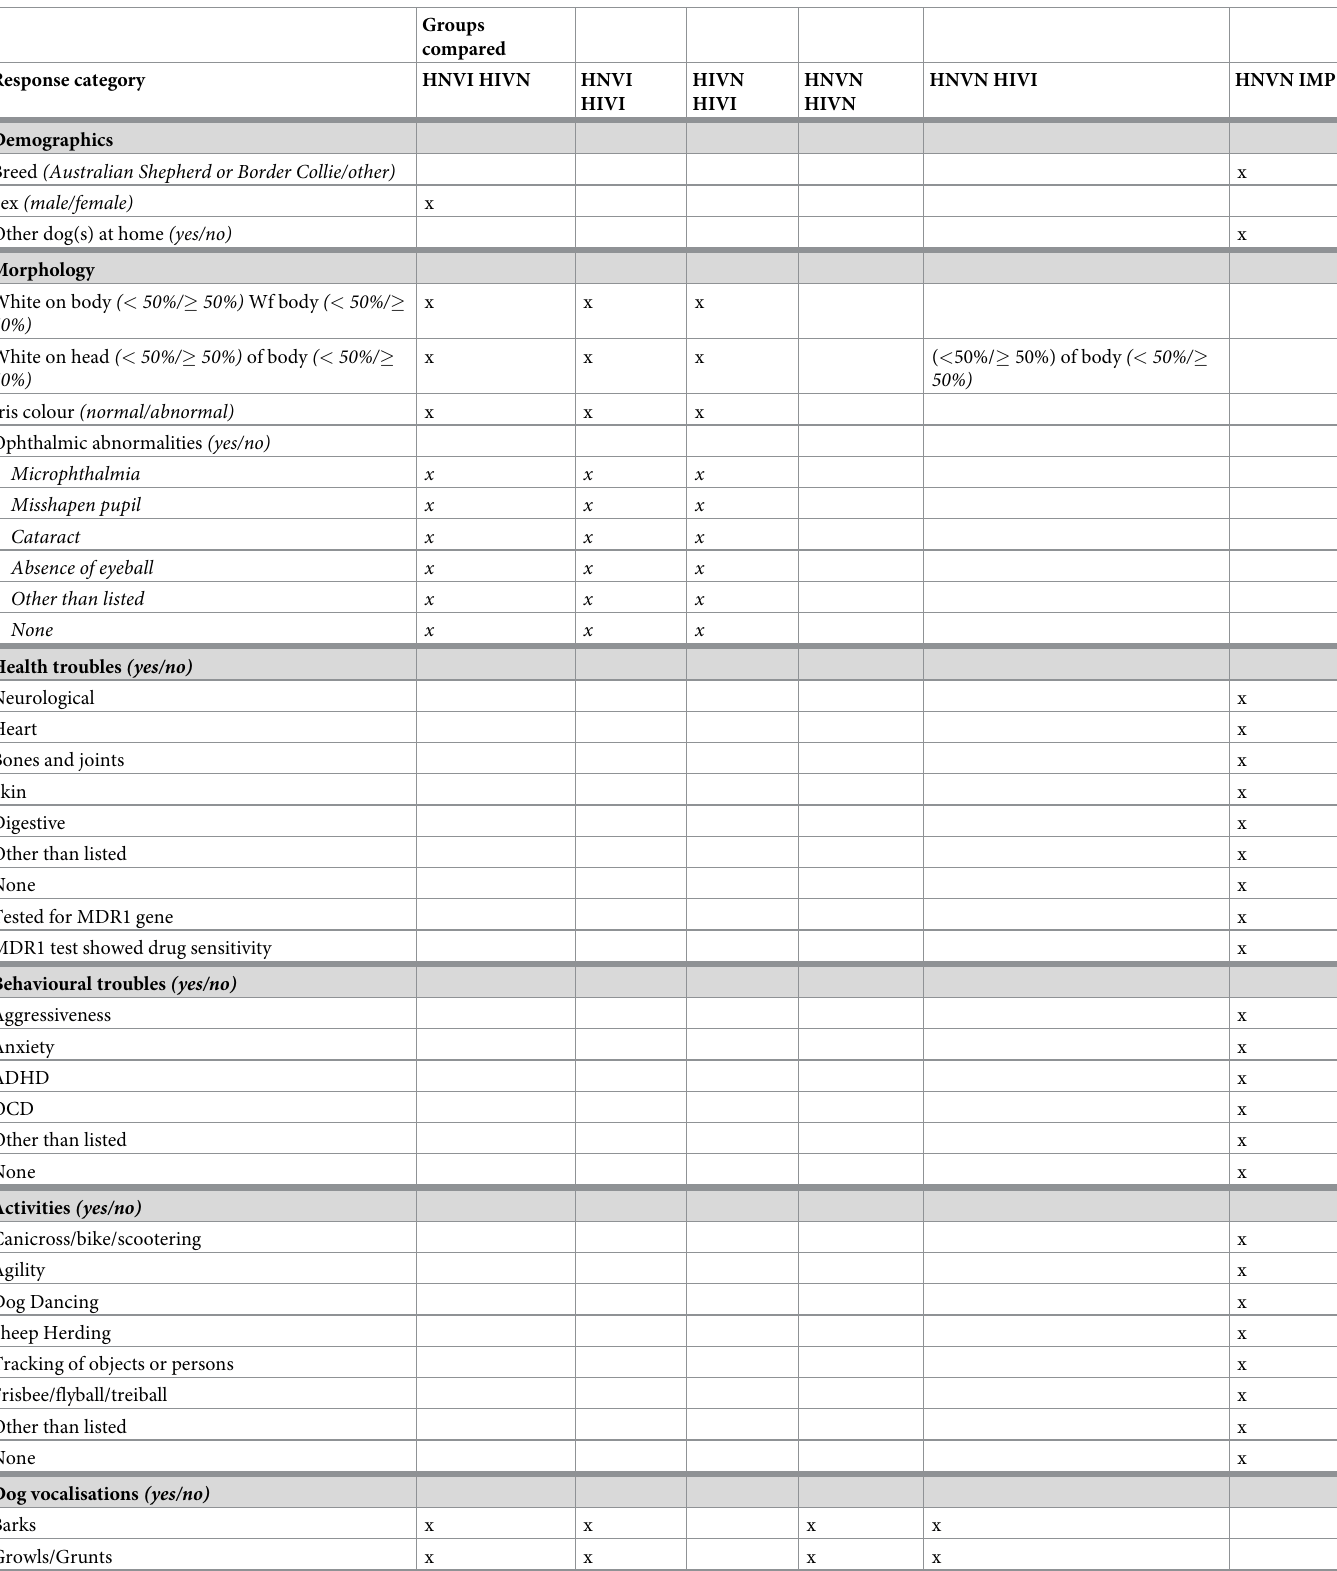
Table 2. List of two-by-two comparisons between groups assessed using Chi 2